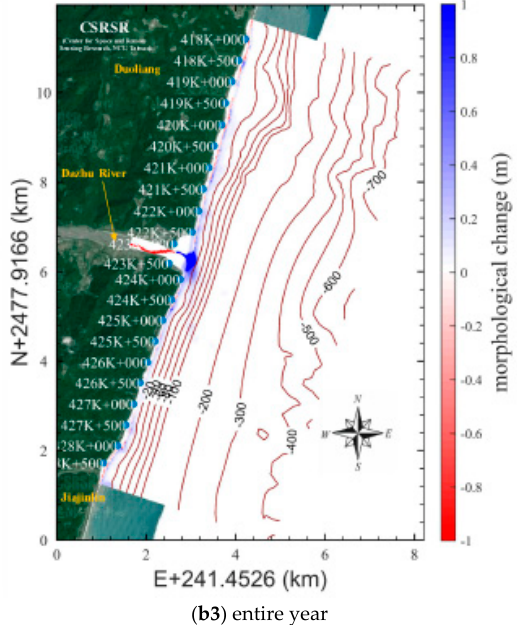
Figure 23. Simulated coastal current and morphological change in Region B. ( a ): coastal current; ( b ): morphological change.